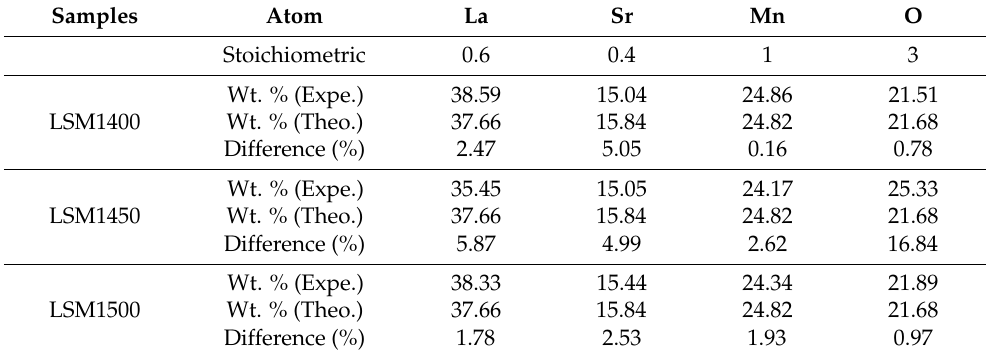
Table 2. Stoichiometric percentage by weight of La 0.6 Sr 0.4 MnO 3 powder samples calcined at differ- ent temperatures.